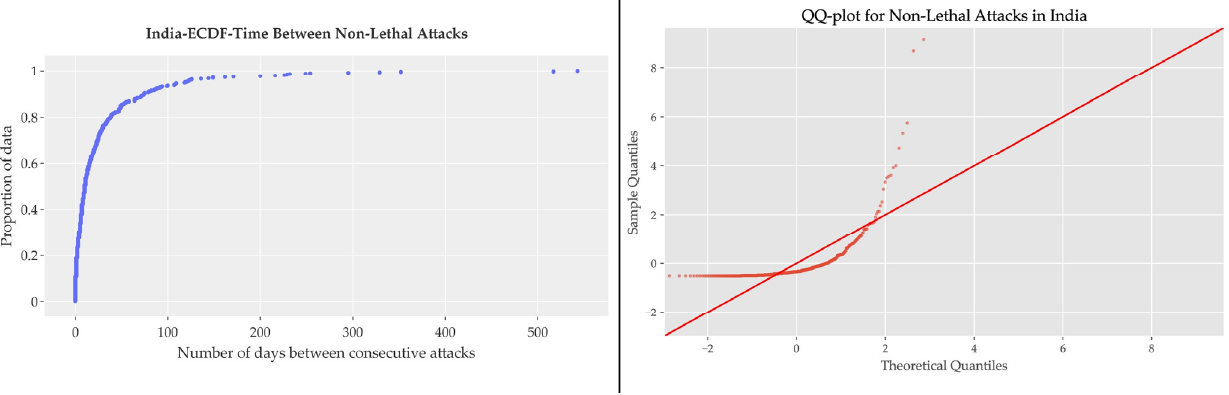
Figure 14. The time between consecutive non-lethal a tt acks and the corresponding QQ plot for